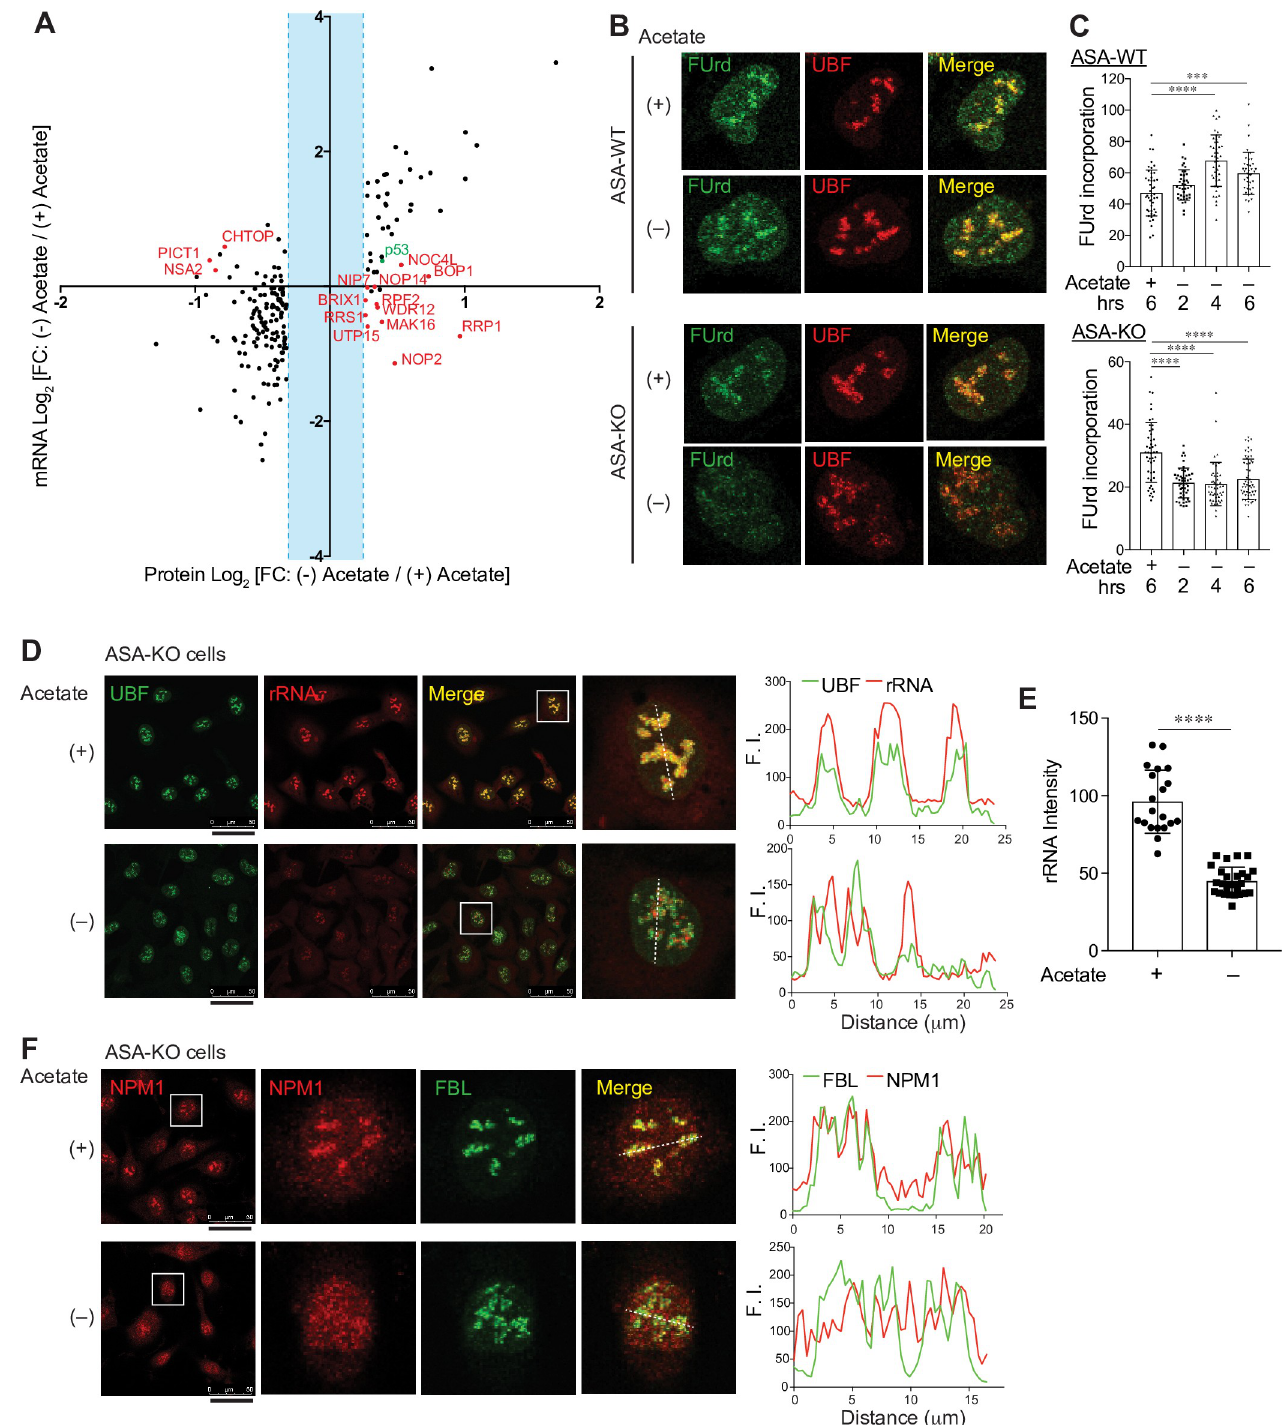
Fig 3. Functional and structural remodeling of the nucleolus by acetyl-CoA depletion. (A) Scatter plot for log 2 FC in proteins (x-axis) and mRNAs (y-axis) 4 hours after acetate removal in ASA-KO cells. Values are from S2 and S3 Tables. Proteins with log 2 FC more than 0.264 or less than − 0.322 are shown. Proteins that are known to localize in the nucleolus are highlighted in red and p53 is shown in green. (B) FUrd incorporation assay in ASA-WT and ASA-KO cells cultured in 1% FBS containing media with or without 20-mM acetate over 6 hours. Representative nuclear images immunostained for FUrd and UBF are shown. (C) Quantification of the mean fluorescent intensity of the FUrd signal per nucleus. The microscopic images of the FUrd incorporation assay performed as in “B” were utilized for the quantification. Data are shown as mean ± SD ( n = 39 to 55 cells per condition). ��� P < 0.001, ���� P < 0.0001 (1-way